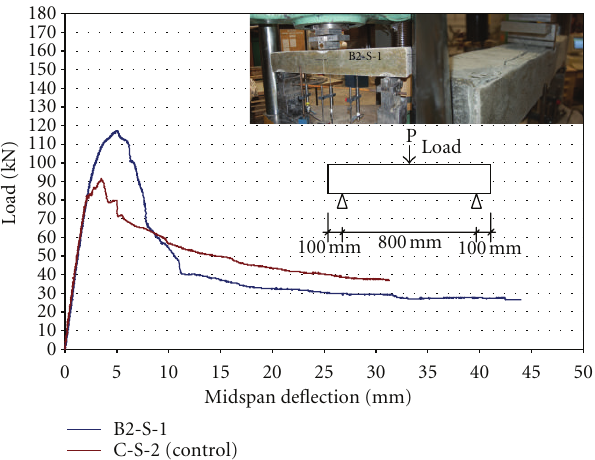
Figure 18: Load versus midspan deflection of RC beam B2-S-3.